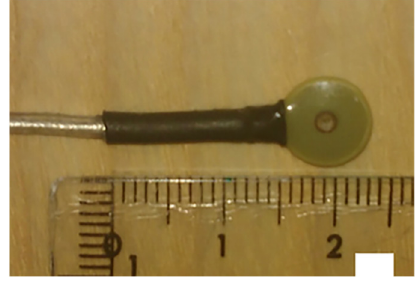
Figure 3. Head Position Indicator (HPI) coil used for co-registration purposes. Reprinted from [31]. (Copyright 2018 PLOS) Image reproduced as per terms of CC BY 4.0 license. Further, anatomical landmarks, viz., three bony fiducial points (Nasion, left, and right pre-auricular points) and additional points are collected around the subject’s head.